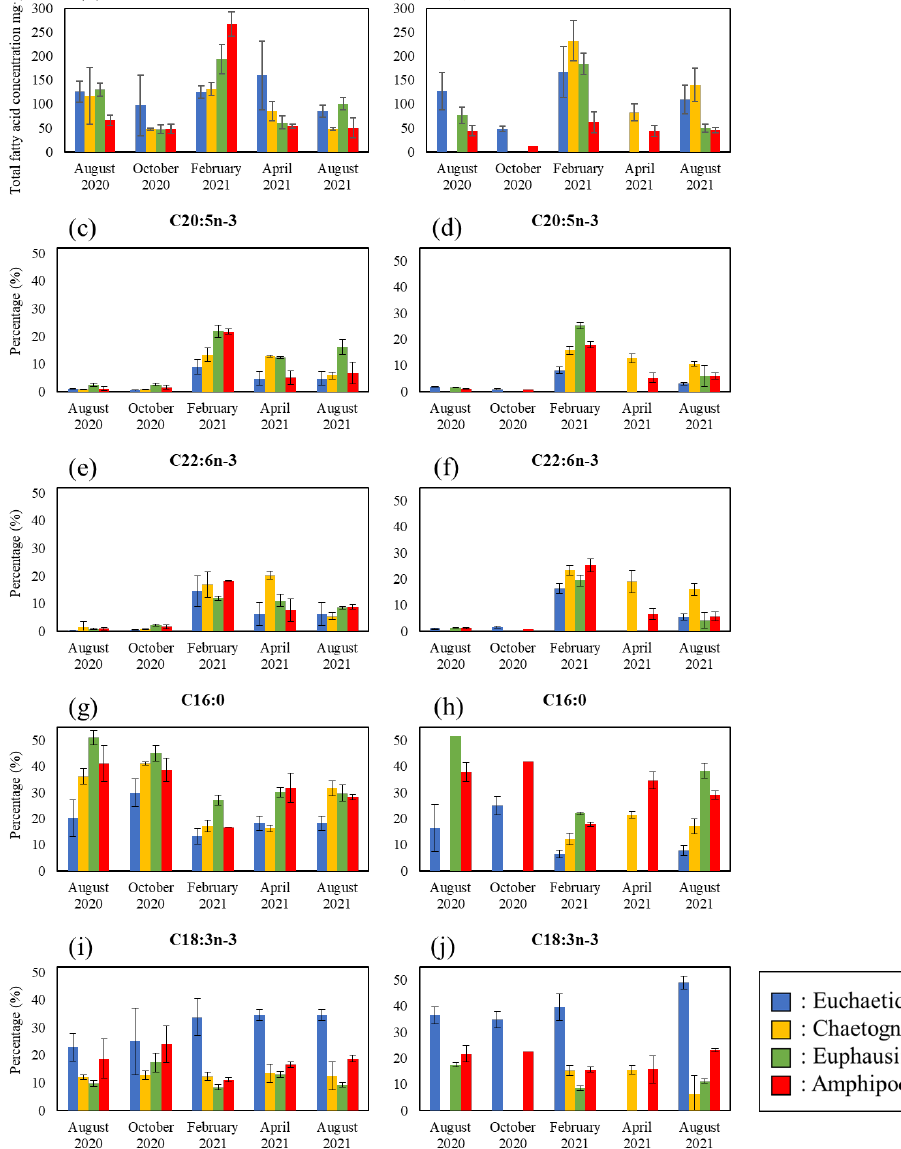
Figure 6. Changes in the total fatty acid (TFA) concentrations ( a , b ), proportions of C20:5(n-3) ( c , d ), C22:6(n-3) ( e , f ), C16:0 ( g , h ), C18:3(n-3) ( i , j ) best representing seasonal dissimilarity in 105-05 ( a , c , e , g , i ) and 105-11 ( b , d , f , h , j ) based on SIMPER analysis. Each color represents different zooplankton taxa (Blue: Euchaetidae, Yellow: Chaetognatha, Green: Euphausiid, Red: Amphipod). Four FAs, C16:0, C18:3(n-3), C20:5(n-3), and C22:6(n-3), 63% of total FAs, were